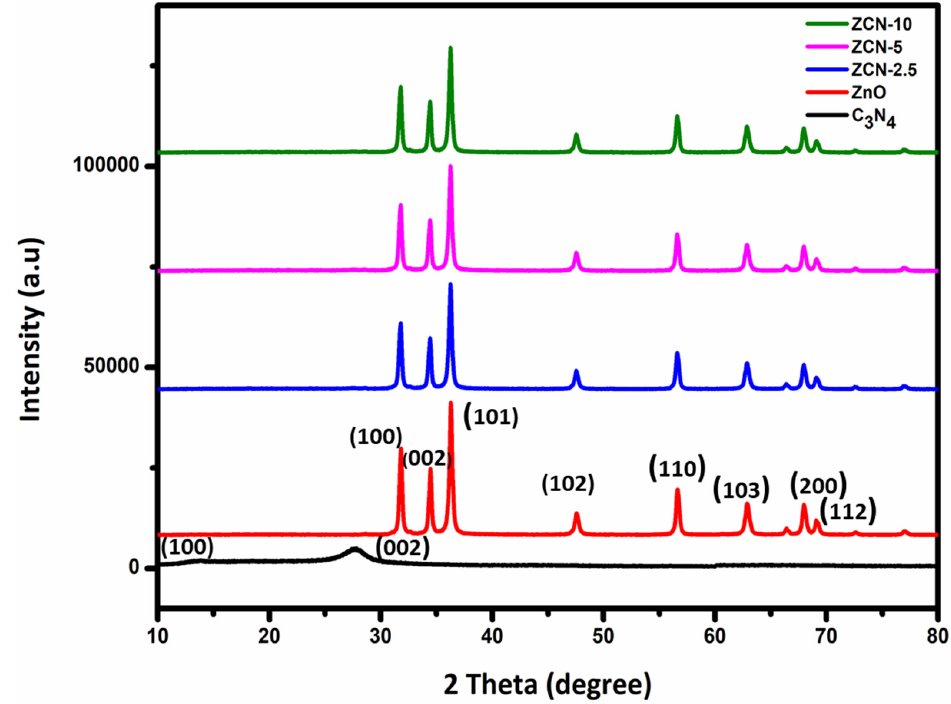
Figure 2. The PXRD patterns of ZnO and composites of ZnO/C 3 N 4 . The optical properties of ZnO, C 3 N 4 , and ZnO/C 3 N 4 photocatalysts were studied using UV–Vis diffuse reflectance spectra, as shown in Figure 3a. The absorption edge of ZnO and ZnO/C 3 N 4 composites (ZCN-5) were observed at 399 nm and 450 nm, respectively. The absorption edge of the ZnO/C 3 N 4 hybrid (ZCN-5) shifted to a longer wavelength of 450 nm compared with ZnO. The bandgap energy of these materials was ZCN-5, respectively. The lowering of the bandgap to 2.91 eV for ZnO/C 3 N 4 composites (ZCN-5) is due to the strong interfacial coupling between ZnO and C 3 N 4 [77,78]. Figure 3. ( a ) UV DRS spectra ZnO and composites of ZnO/C 3 N 4 ; ( b ) Tauc plot of ZnO and compo- sites of ZnO/C 3 N 4 (ZCN-5).